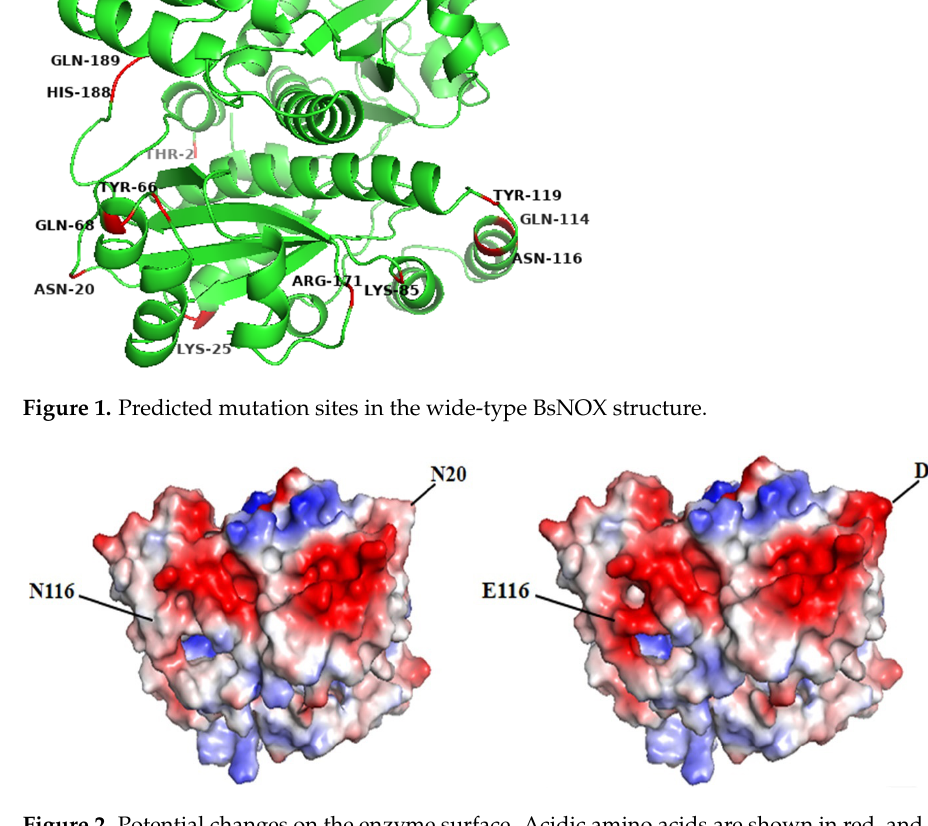
Figure 2. Potential changes on the enzyme surface. Acidic amino acids are shown in red, and alkaline amino acids are shown in blue. Left: the wild-type BsNOX. Right: the N20D/N116E variant.